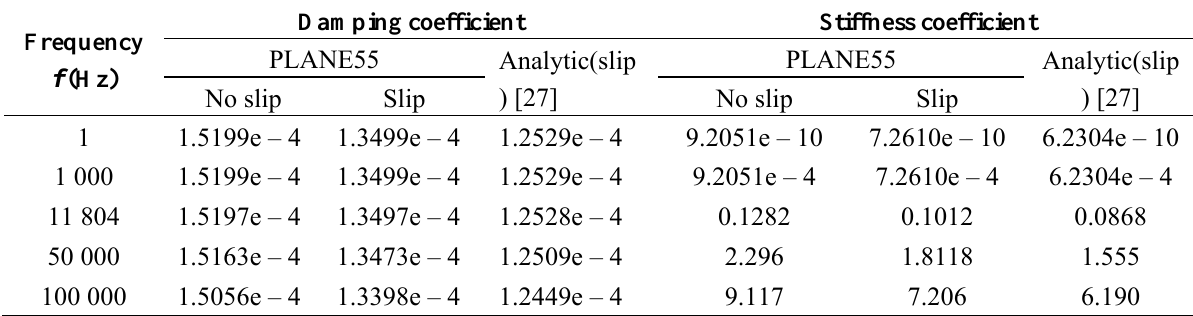
Table 2. Effective damping and stiffness coefficients of the squeeze film at different frequencies.